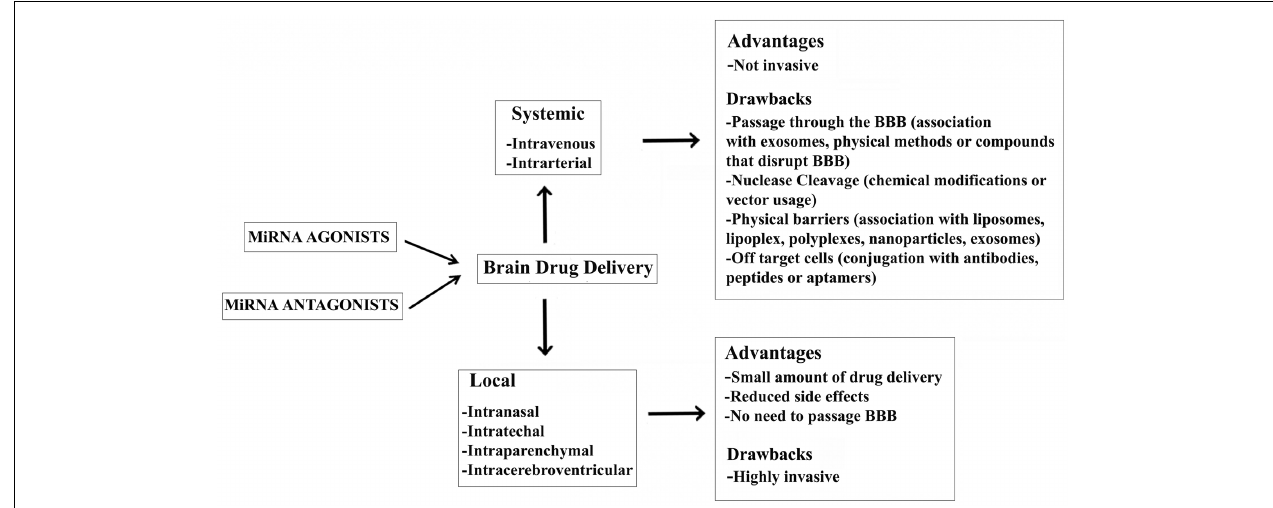
FIGURE 1 | Advantages and drawbacks of a miRNA-based therapy for the treatment of